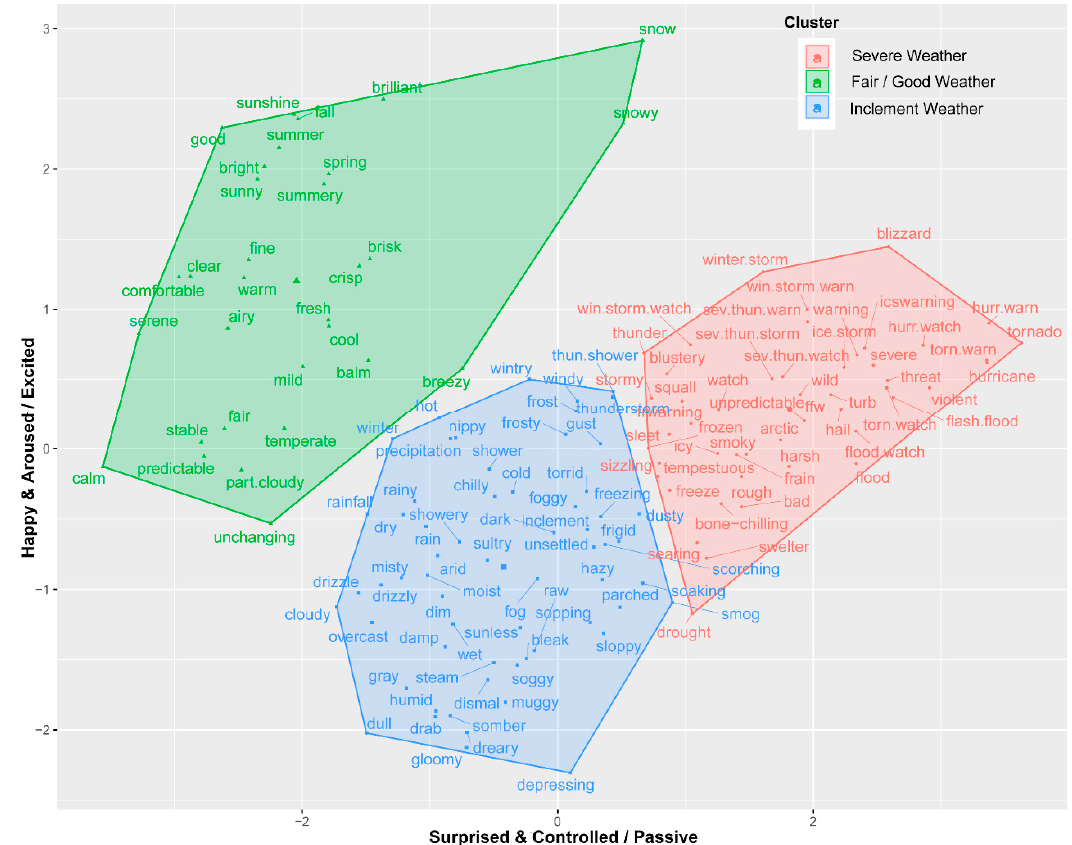
Figure 1. Weather word cluster membership in two-dimensional space. Note that some words have been abbreviated from their original form in Table 1.